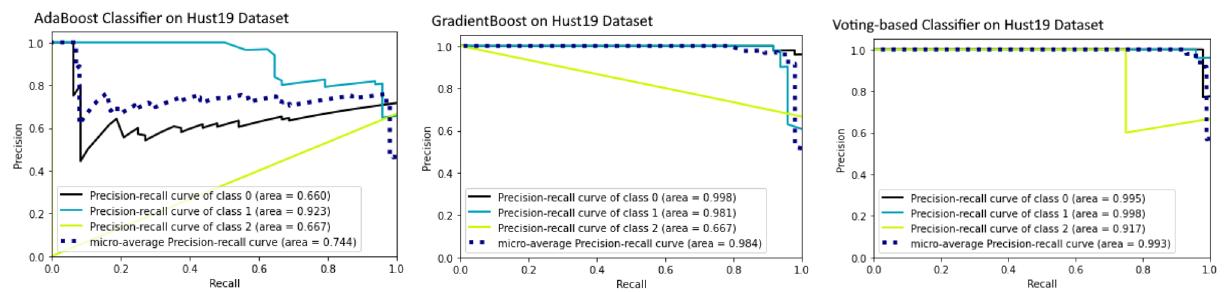
Figure 6. Performance evaluation of ensemble classifier on Hust19 Data-set ( a ) AdaBoost ( b ) GradientBoost ( c ) voting-based classifier.